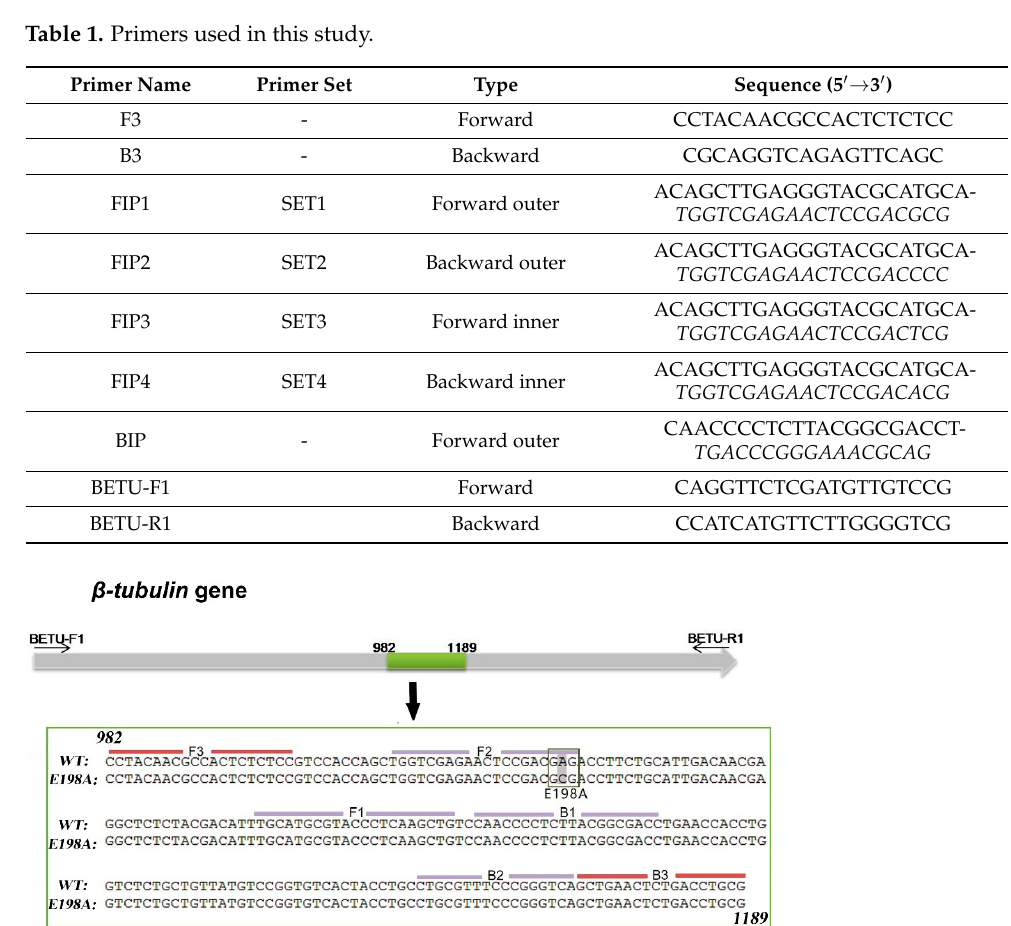
Figure 2. Schematic representation of the site of the β -tubulin gene fragment containing codon 198 and the E198A-LAMP assay. The LAMP assay was performed in a dry thermostat with a total of 25 μ L. The com- ponents of the LAMP reaction mixture contained 10× Thermopol (Vazyme, Nanjing,